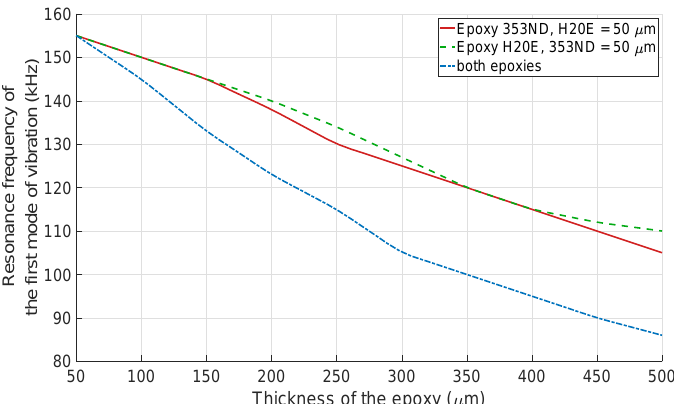
Figure 9. The FEM simulation of the resonance frequency of the first mode of vibration with respect to the thicknesses of the 353ND and H20E